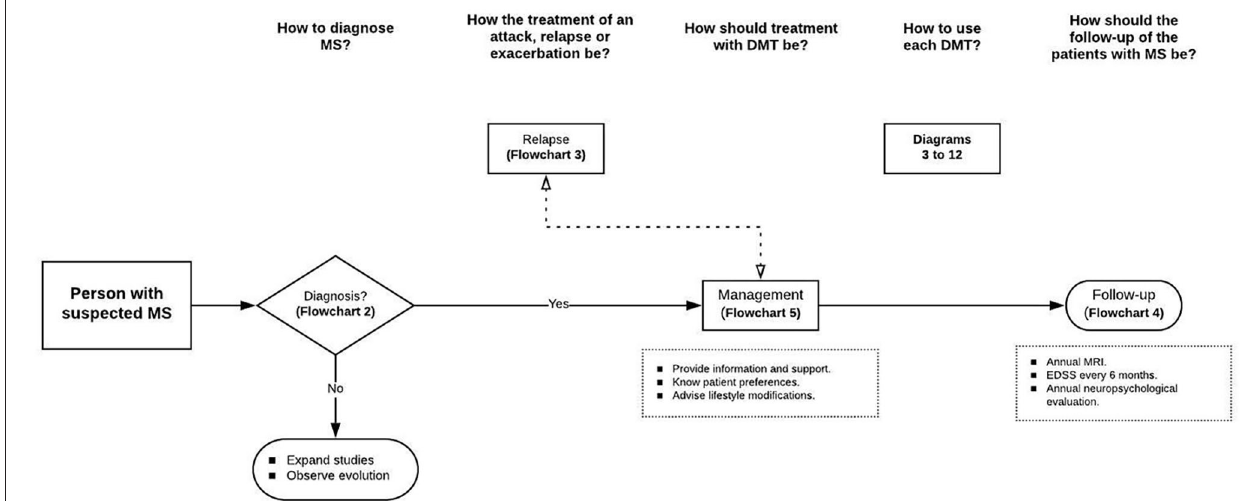
FIGURE 1 | Clinical pathway for diagnosis and treatment of RRMS. Source: Authors.